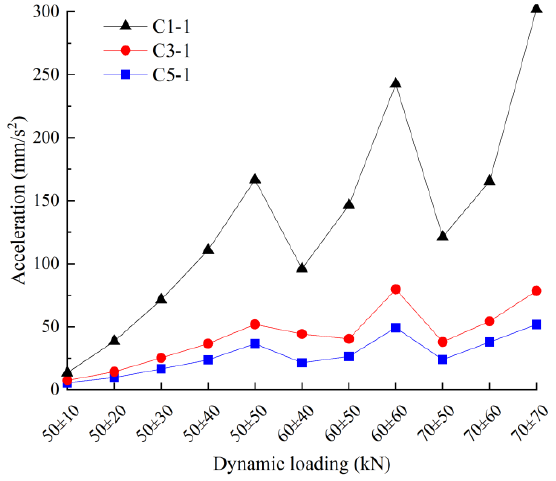
Figure 12. Distribution pattern of acceleration peaks at different depths.